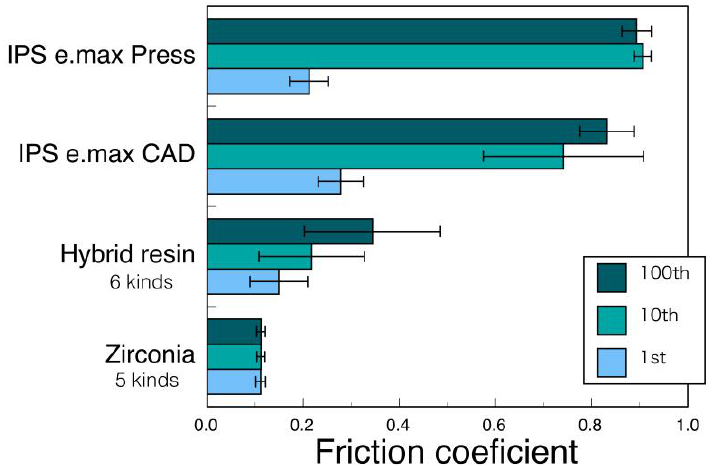
Figure 20. Friction coefficients of two glass ceramics, six kinds of hybrid resin, and five kinds of zirconia against steatite ball in water. Adopted from Ref. [61].